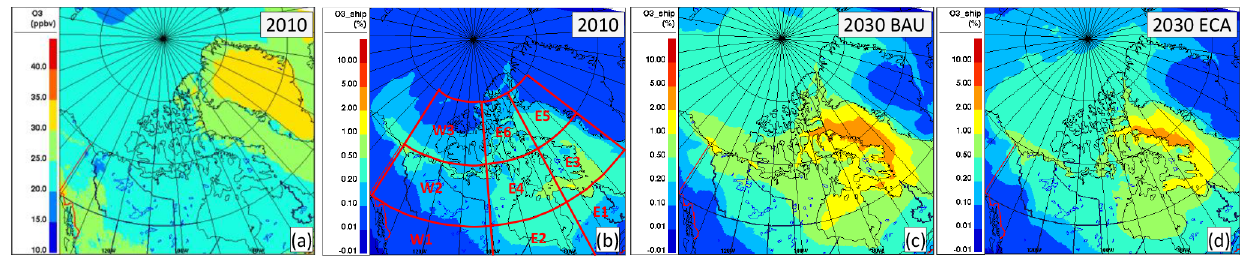
Figure 9. Modelled mean ambient O 3 concentrations for July–August–September (shipping season) of 2010 base year (a) , and relative contribution from Canadian Arctic shipping emissions for the 2010 base year (b) , 2030 BAU (c) , and 2030 ECA (d) . (The geographical subdivisions indicated on (b) are referred to in the statistical assessment).